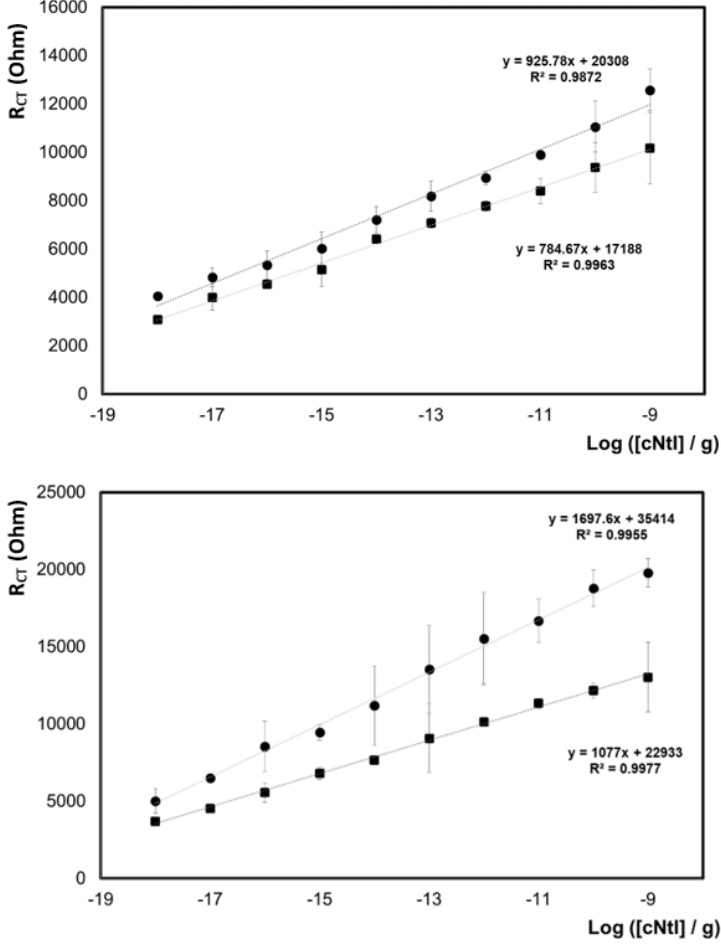
Figure 12. ( A ) Dependence of interfacial resistance (n = 3) on cTnI concentration where the primary antibodies are mAb20B3 ( ● ) and mAb228 ( ■ ), following exposure to increasing cTnI target (1 ag/mL to 1 ng/mL) and after immobilization of the Ir (III)-labeled commercial secondary antibody mAb19C7 ( B ). In all cases, the supporting electrolyte is 1 mM DPBS and EIS was recorded between 0.01 and 100,000 Hz using an alternating current (ac) amplitude of 25 mV. Reproduced with permission from [83].